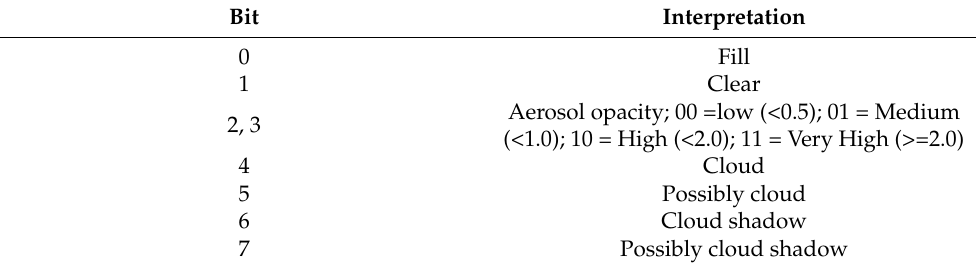
Table 5. GF1-WFV ARD quality assessment bit-packing detail. Bits are numbered from right to left where bit 0 = the Least Significant Bit and bit 7 = the Most Significant Bit.